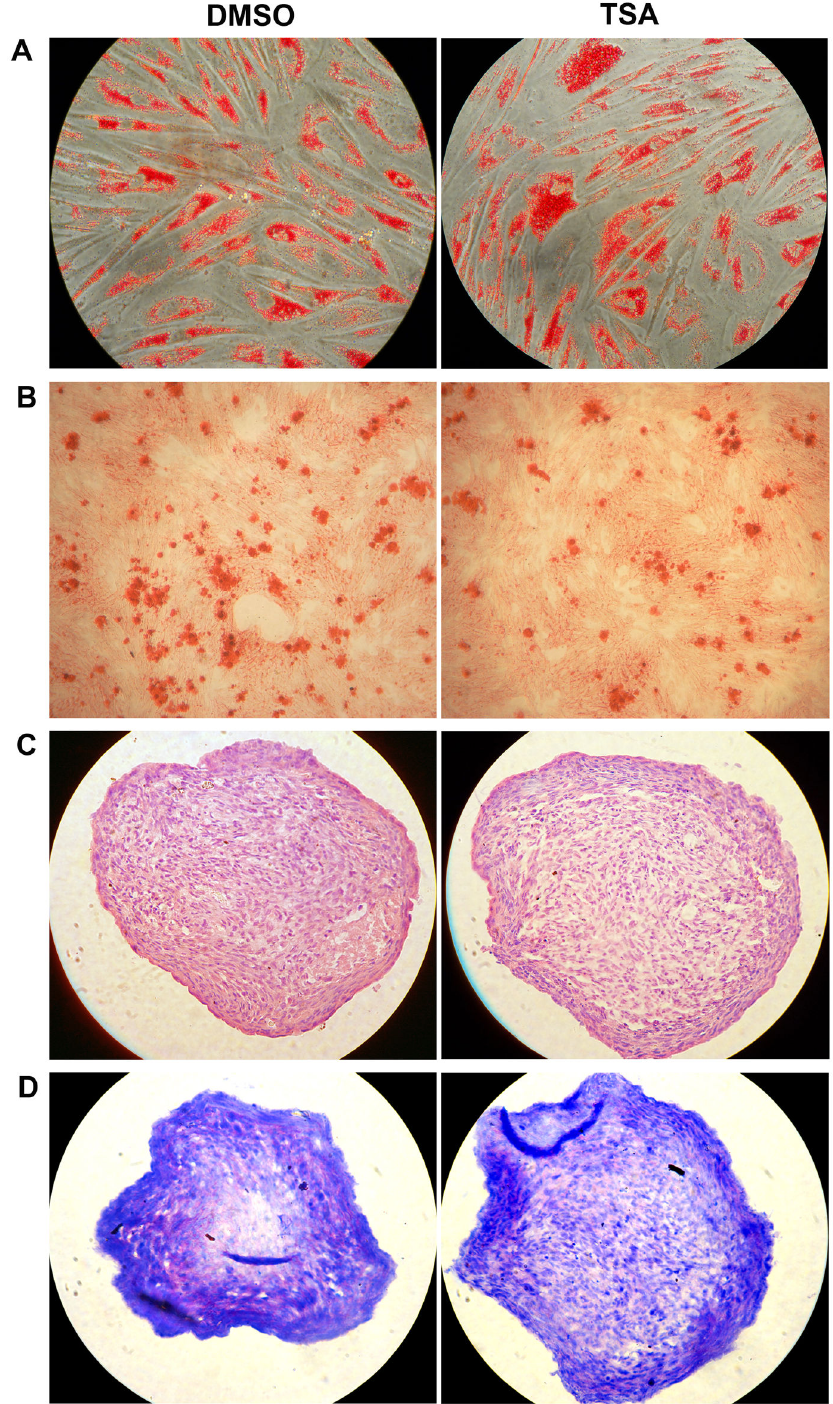
Figure 4. Differentiation of hMSCs. Passage (P)1 hMSCs were grown in the presence of TSA (at 6.25 nM) or vehicle DMSO to passage 6. Then the cells were incubated in adipogenic (A), osteogenic (B) and chondrogenic (C and D) induction media, respectively. MSCs differentiated into adipocytes (A, with oil red staining), osteoblasts (B, with Alizarin Red S staining) and chondrocytes (cultured in micromass and sectioned: C, with H&E staining; D, with toluidine blue staining showing pink extracellular matrix proteoglycans). The experiments were repeated three times with similar results and representative results from one experiment were shown. doi: 10.1371/journal.pone.0081781.g004 PLOS ONE |